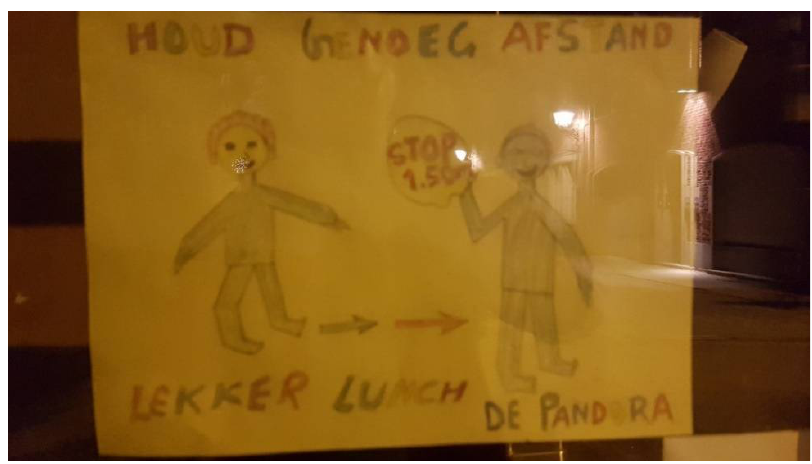
Figure 4. Keep enough distance